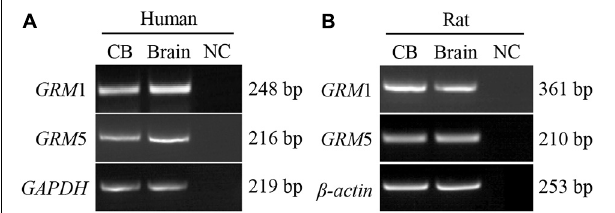
FIGURE 1 | mRNA expression of group I mGluRs in human and rat CB. (A,B) Representative agarose gel images show the RT-PCR results of group I mGluR mRNA expression in human and rat CB. CB, left lanes in (A,B) . RNA extracted from the human brain cerebral cortex was used as positive control (brain, middle lanes in A,B ). An equal volume of the negative cDNA control was used in the PCR as PCR negative control (NC; right lanes in A,B ). GRM, glutamate metabotropic